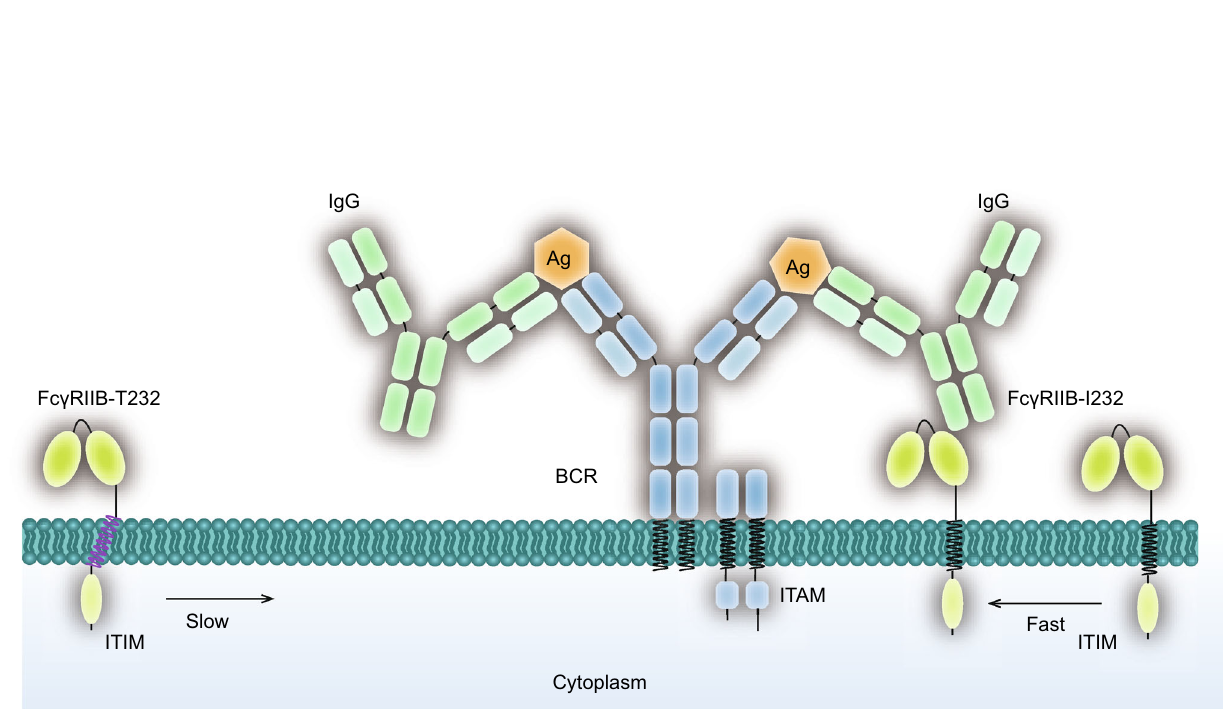
Figure 4. The “ catch-me-if-you-can ” model. The model indicates that the fast lateral mobility of Fc γ RIIB is crucial for its inhibitory function. Due to the high af fi nity between BCR and antigen, the BCR is more likely to catch the antigen before Fc γ RIIB catch the IgG upon immunocomplex stimulation. Then the low af fi nity Fc γ RIIB-WT has to diffuse fast enough to catch the IgG and stop the BCR signaling in time. In marked contrast, Fc γ RIIB-I232T fails to “ catch ” the IC due to its slow diffusion and thus loses its inhibitory